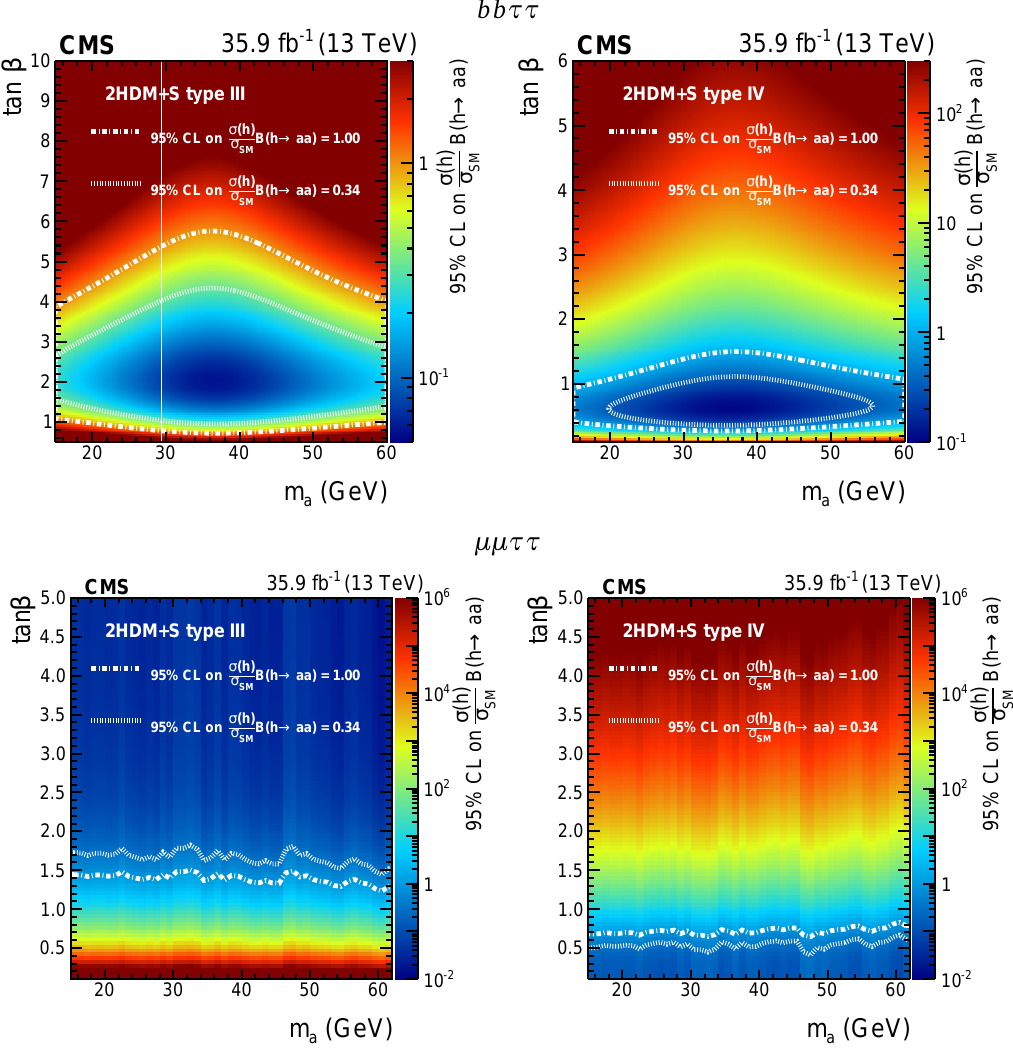
) × B ( h → aa ) in 2HDM + S of type Figure 9: Observed 95% CL limits on ( σ ( h ) /σ SM III (left), and type IV (right). The contours corresponding to a 95% CL exclusion ) × B ( h → aa ) = 1.00 and 0.34 are drawn with dashed lines. The of ( σ ( h ) /σ SM number 34% corresponds to the limit on the branching fraction of the Higgs boson to beyond-the-SM particles at the 95% CL obtained with data collected at center-of- mass energies of 7 and 8 TeV by the ATLAS and CMS experiments [ 19 ] . [ 20,21